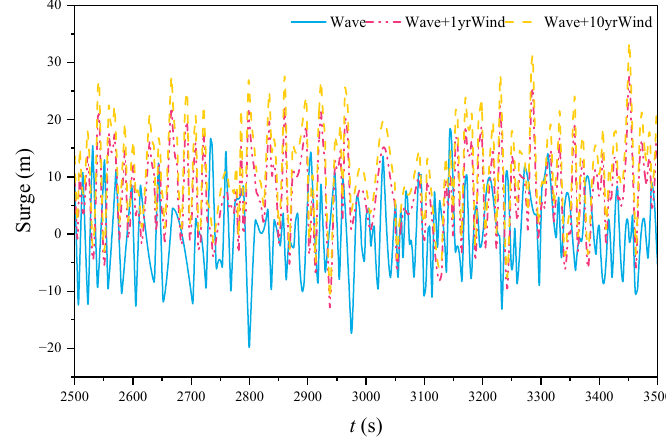
Figure 16. Surge response under wave load and wind load.